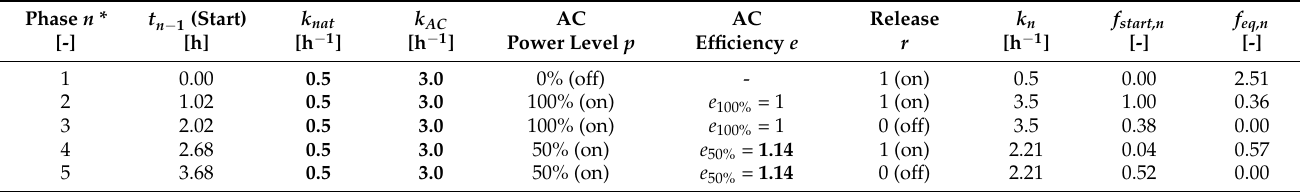
Table 4. Known parameters t n − 1 , p n , and r , and variable fitting parameters k nat , k AC , and e 50% for the fitting curve in Figure 3.